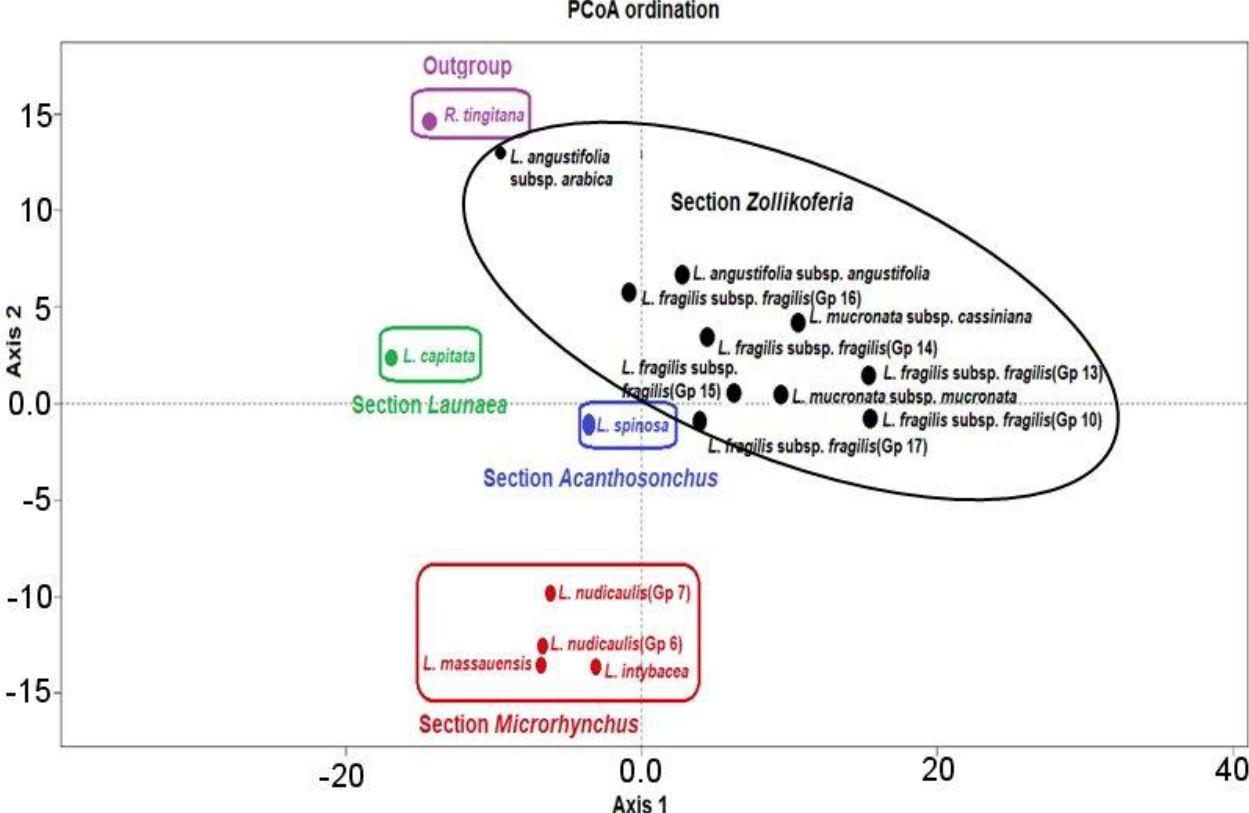
Figure 10. Principal Coordinate Analysis (PCoA) of seventeen samples representing the outgroup Reichardia tingitana and 10 taxa of Launaea based on the achene and the pollen grain micromorphological attributes.